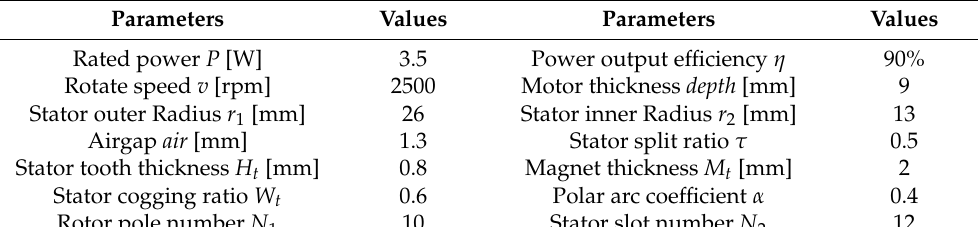
Table 2. Initial structural parameters and performance requirements of the auxiliary generator.